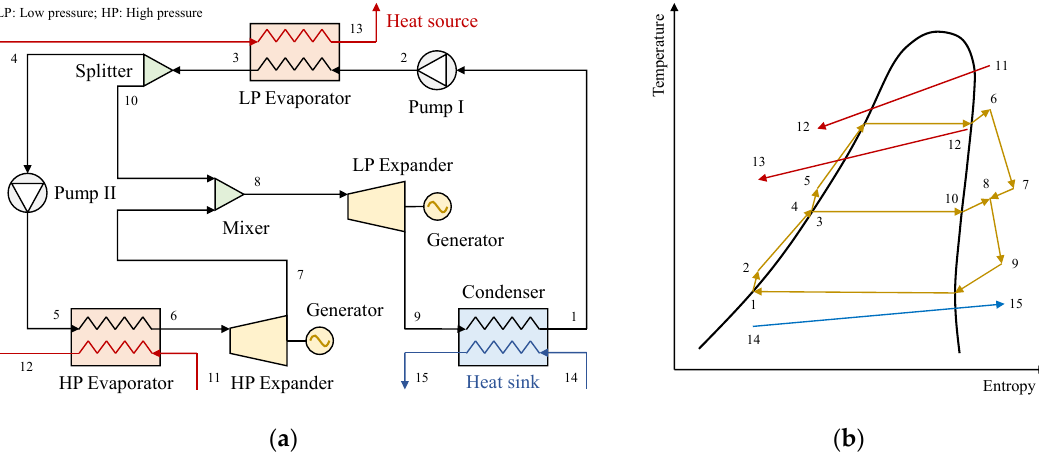
Figure 13. Diagrams of dual − pressure evaporating ORC: ( a ) System configuration; ( b ) Cycle process.